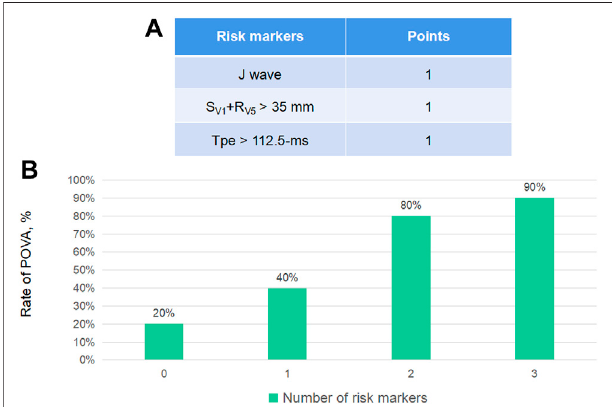
FIGURE 3 | Electrocardiographic markers for POVA and the development of the POVA risk score model, According to the number of risk markers, we assigned points (A) and subsequently developed a model predicting POVA (B)